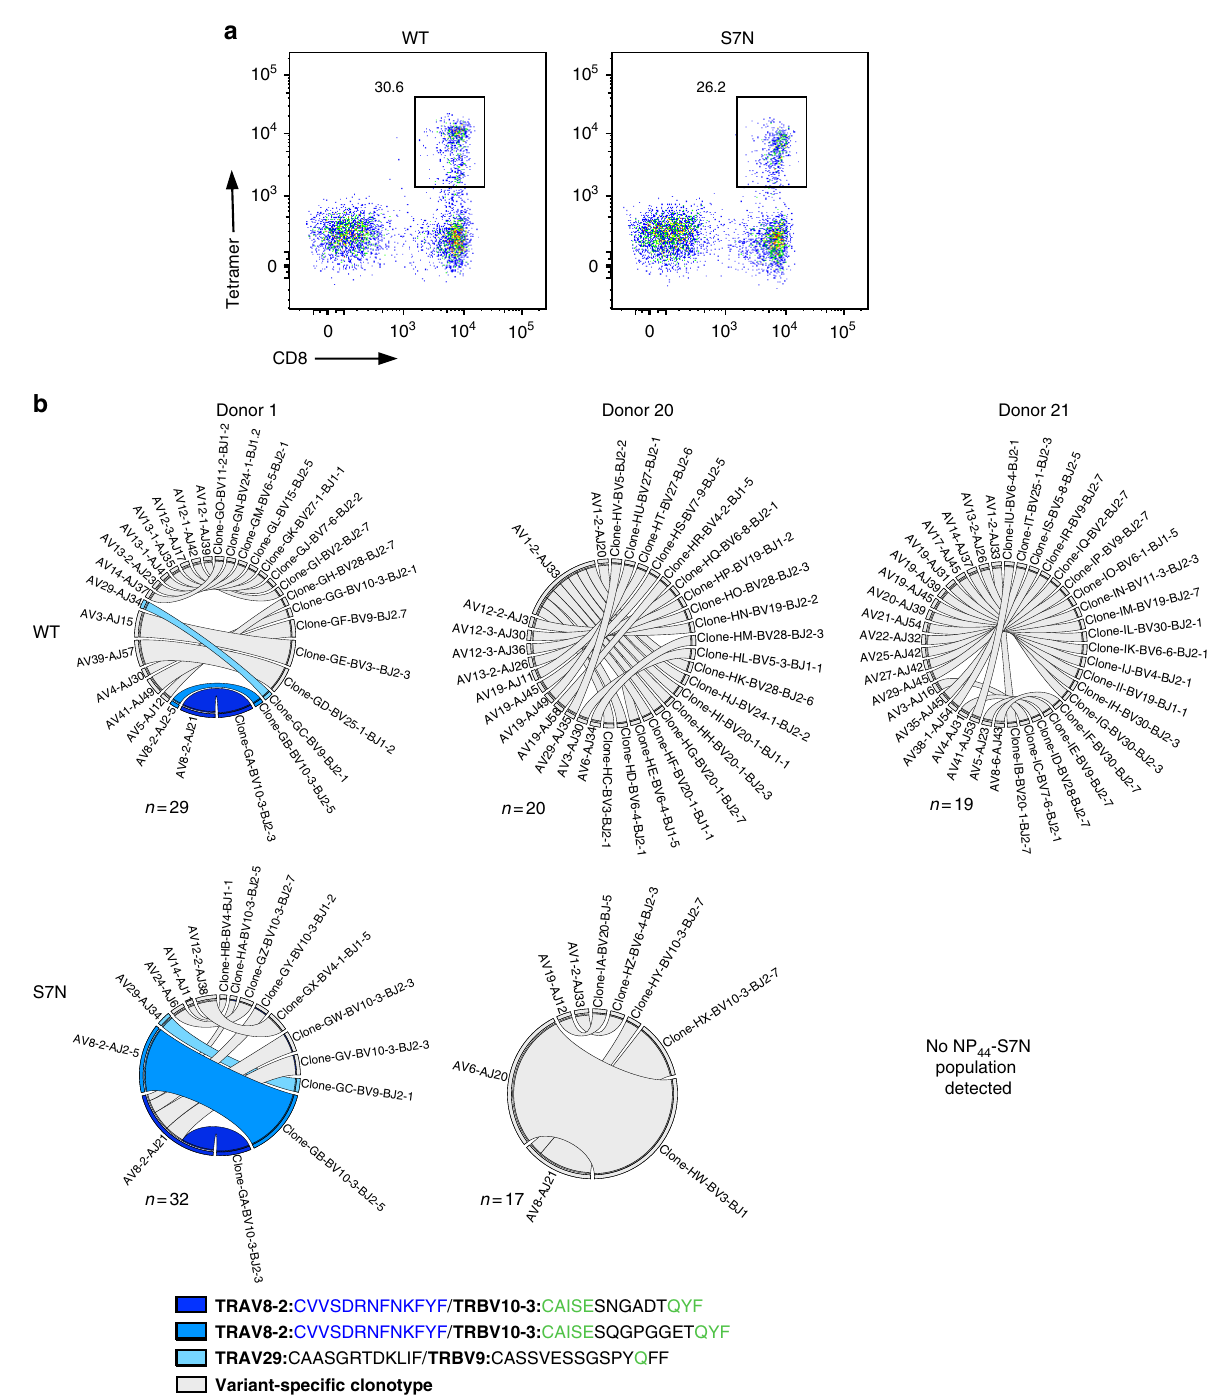
Fig. 8 TCR αβ clonotypes can recognize HLA-A*01:01-restricted NP 44 variants. PBMCs from HLA-A*01:01 + donors (Donors 1, 20 and 21) were tetramer stained individually with each of the NP 44 tetramers conjugated to PE. Samples were enriched, surface stained, and single-cell sorted on lymphocytes, singlets, CD3 + live + dump − cells, CD8 + tet + cells, as per Supplementary Figure 2c, and the TCR αβ repertoire was determined using a multiplex RT-PCR. a Representative dot plots of NP 44 tetramer staining of CD3 + T cells following magnetic enrichment. Numbers are represented as a proportion of tetramer + of CD8 + T cells. b Summary of the TCR αβ repertoire used by each of the three donors for the recognition of the variant NP 44